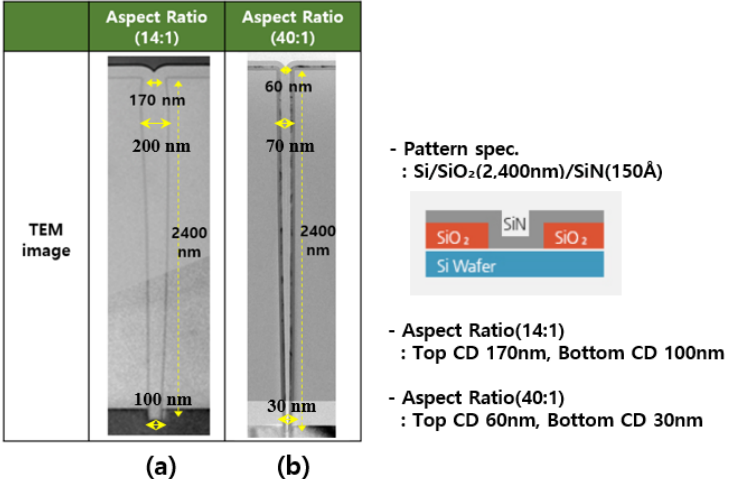
Figure 12. Gap-fill images of the silicon oxide thin film deposited by the DED method. ( a ) Aspect Ratio 14:1. ( b ) Aspect Ratio